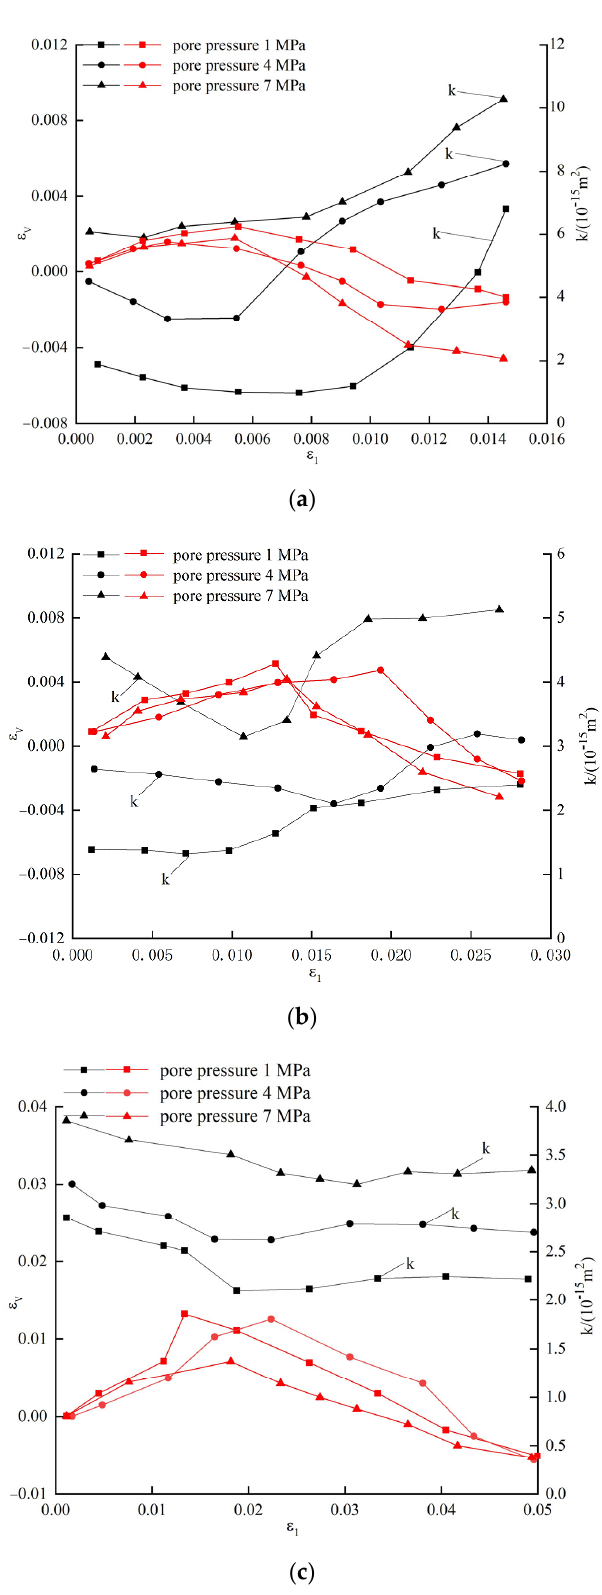
Figure 8. Volumetric strain, axial strain and permeability, axial strain of sandstone under different confining pressures. ( a ) Confining pressure 10 MPa; ( b ) confining pressure 20 MPa; ( c ) confining pressure 30 MPa.